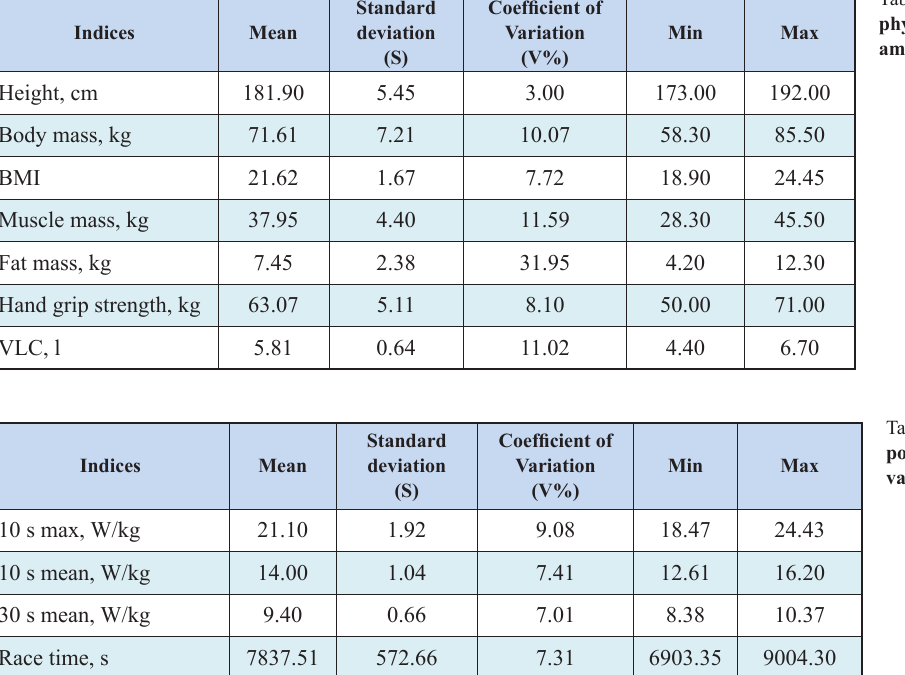
Table 1. Anthropometric and physiometric characteristics of amateur mountain bikers